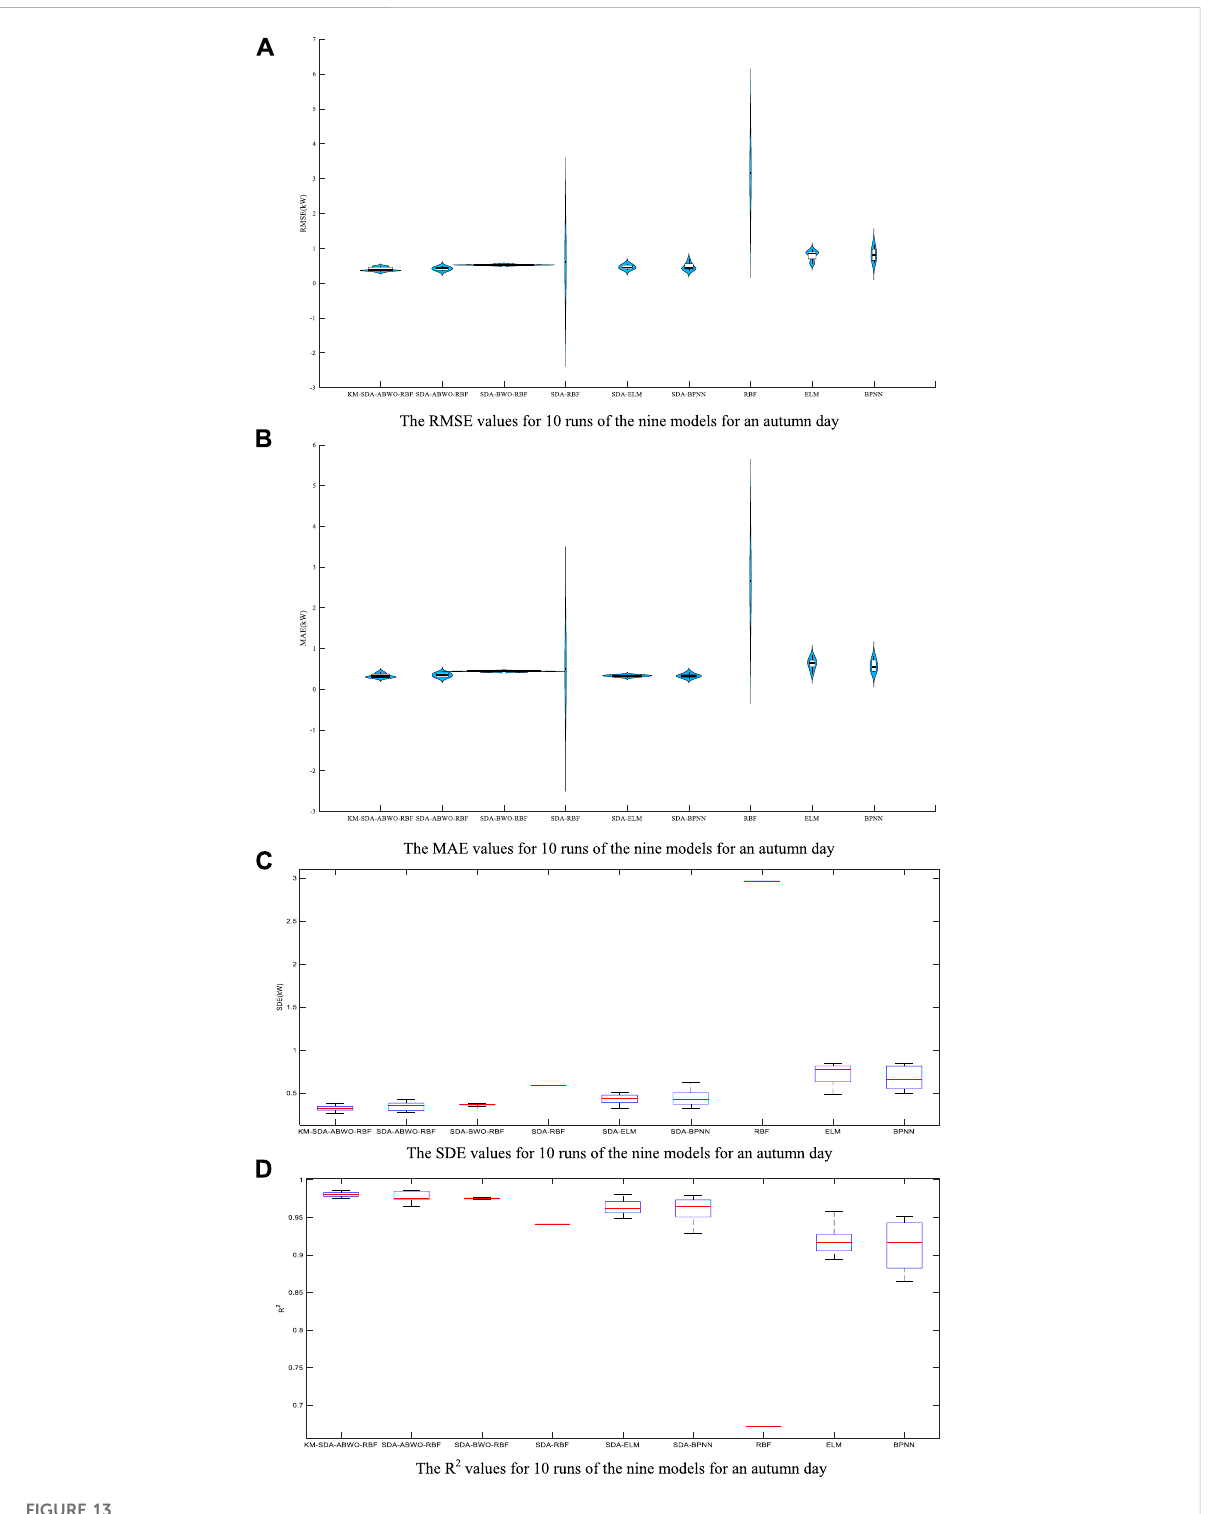
FIGURE 13 (A – D) show the RMSE, MAE, SDE, and R 2 values for 10 runs of 9 models for an autumn